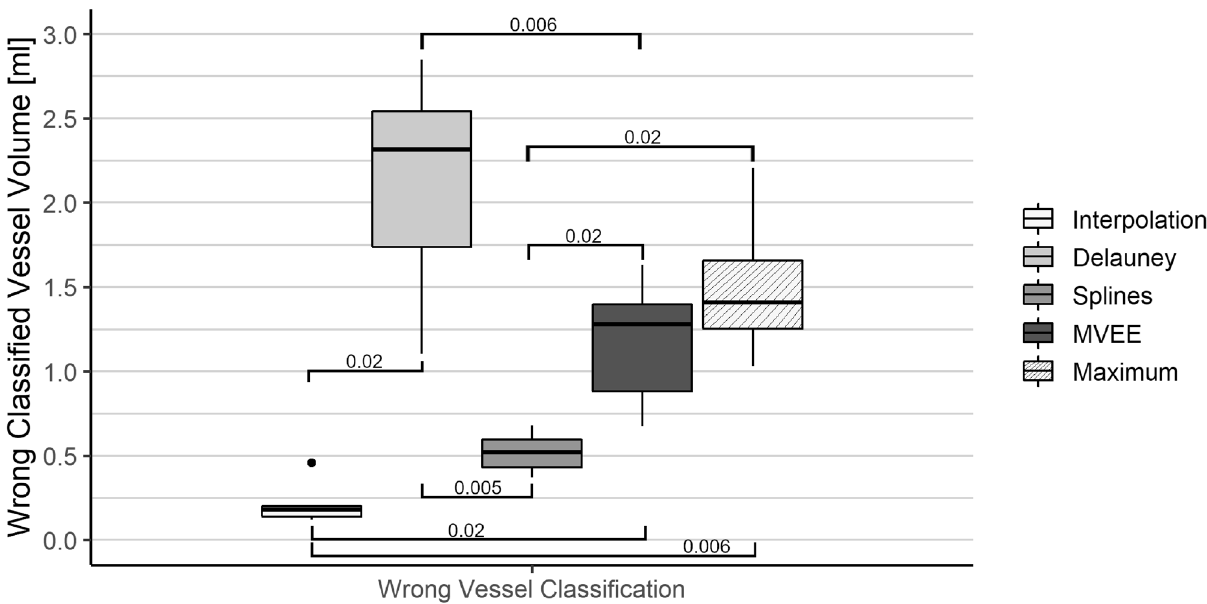
Figure 6. Results of the adaptability tests. The volume of the wrongly classified voxels can be seen for each of the four algorithms. In addition, the boxplot “Maximum” indicates the true vessel volume affected by the coagulation necrosis over all six perfusion phantoms. Horizontal lines indicate statistically significant post-hoc pairwise t-test